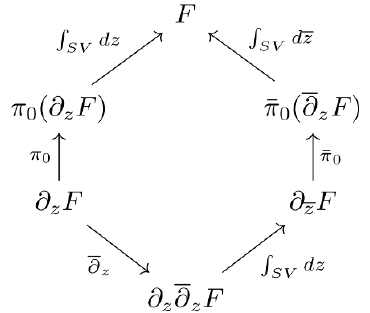
Figure 1 . Commutative diagrams of ref. [11] illustrating the computation of the single-valued